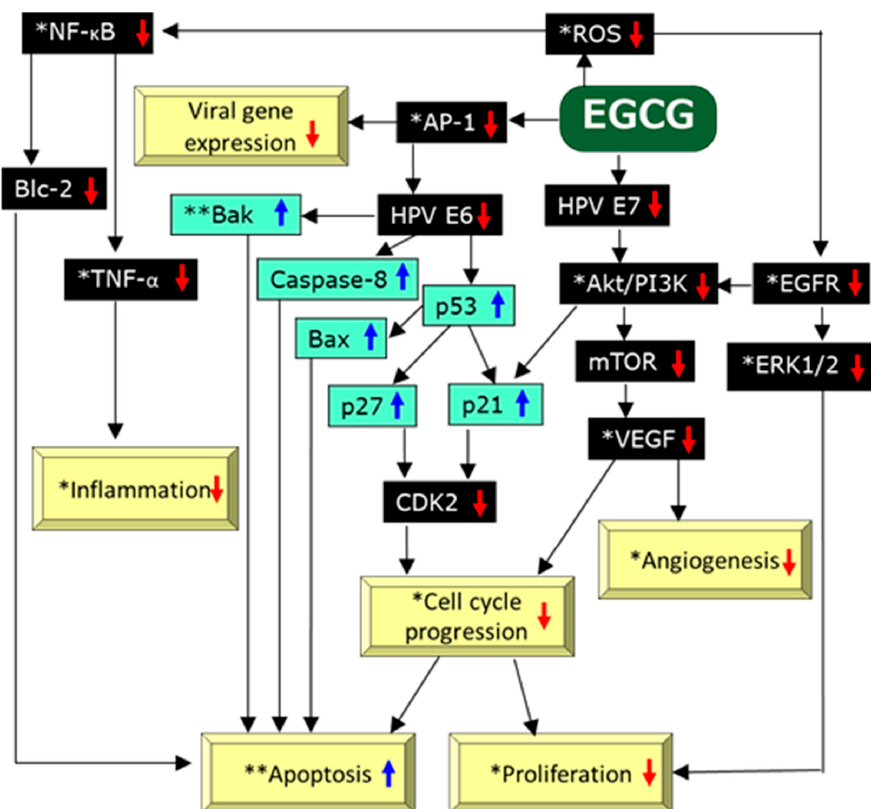
Figure 2. Possible mechanisms of actions of EGCG on HPV-infected cells adopted from